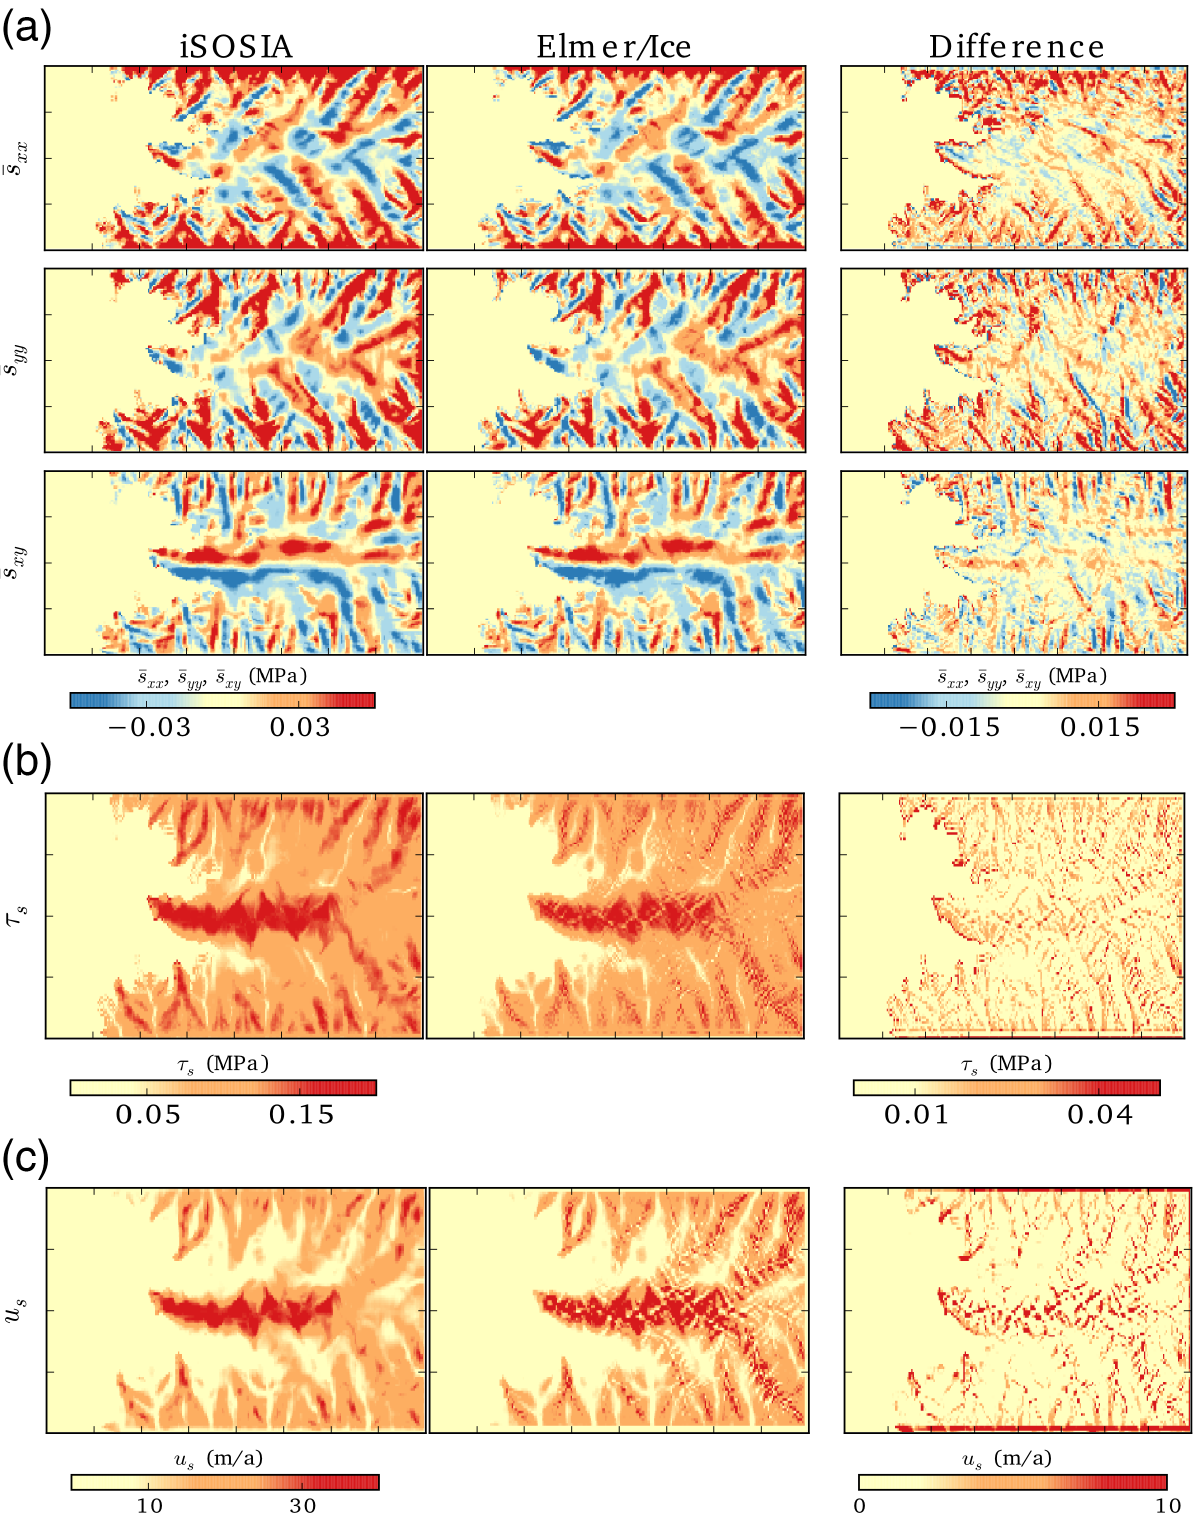
Figure 2. (a) Comparison of stress components from iSOSIA and Elmer/Ice shown in top view. The first two columns show the depth- averaged stress components s xx , s yy , and s xy . The right-most column shows the difference between iSOSIA and Elmer/Ice results. (b) Basal shear stress for both models. (c) Sliding velocity using a Weertman relation (Eq. 6). Ice flow is from right to